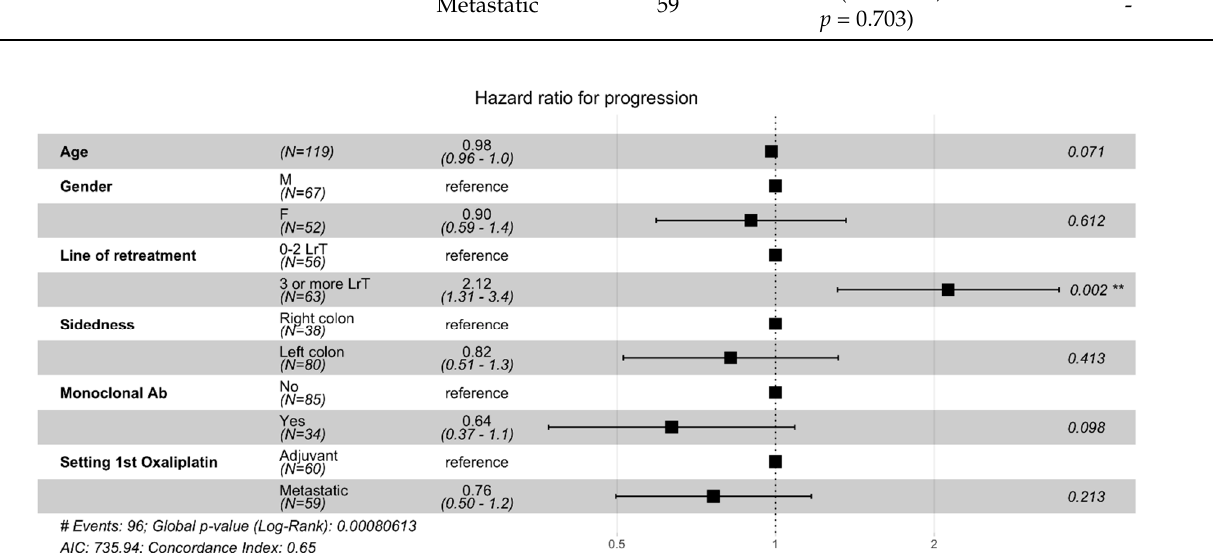
Figure 2. Forest plot depicting the hazard ratios of the multivariate analysis of oxaliplatin retreatment progression-free survival (PFS). Keys: M = male; F = female; LrT = line of retreatment; ** = statistically significant. Table 2. Odds ratios at univariate and multivariate analyses of metastatic colorectal cancer patients who were evaluable for median progression-free survival (mPFS) with oxaliplatin retreatment.